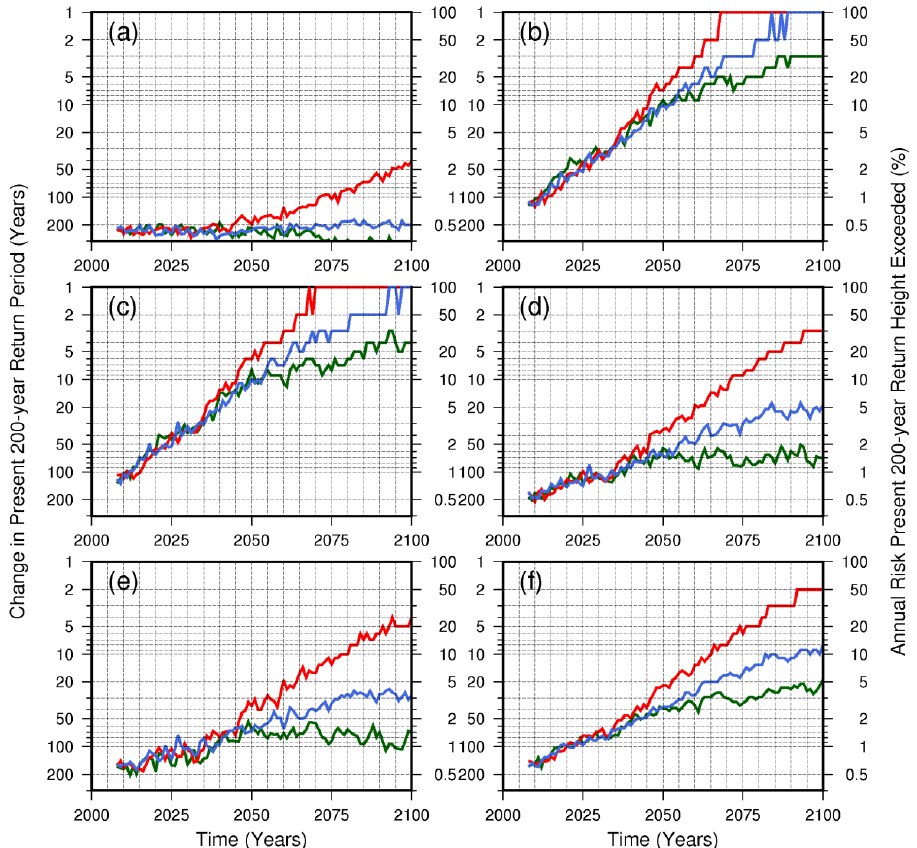
Figure 13. Changes in the 200-year return period (or risk) for the ensemble mean RSL projection for RCP2.6 (green), RCP4.5 (blue) and RCP8.5 (red) and at the locations: ( a ) Oslo; ( b ) Stavanger; ( c ) Bergen; ( d ) Heimsjø; ( e ) Tromsø; and ( f ) Honningsvåg.